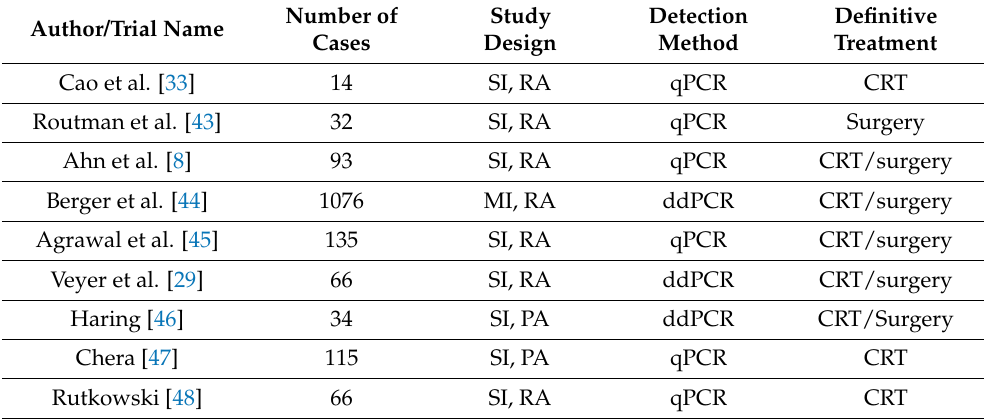
Table 2. Studies investigating ctHPV DNA as a cancer surveillance tool after definitive